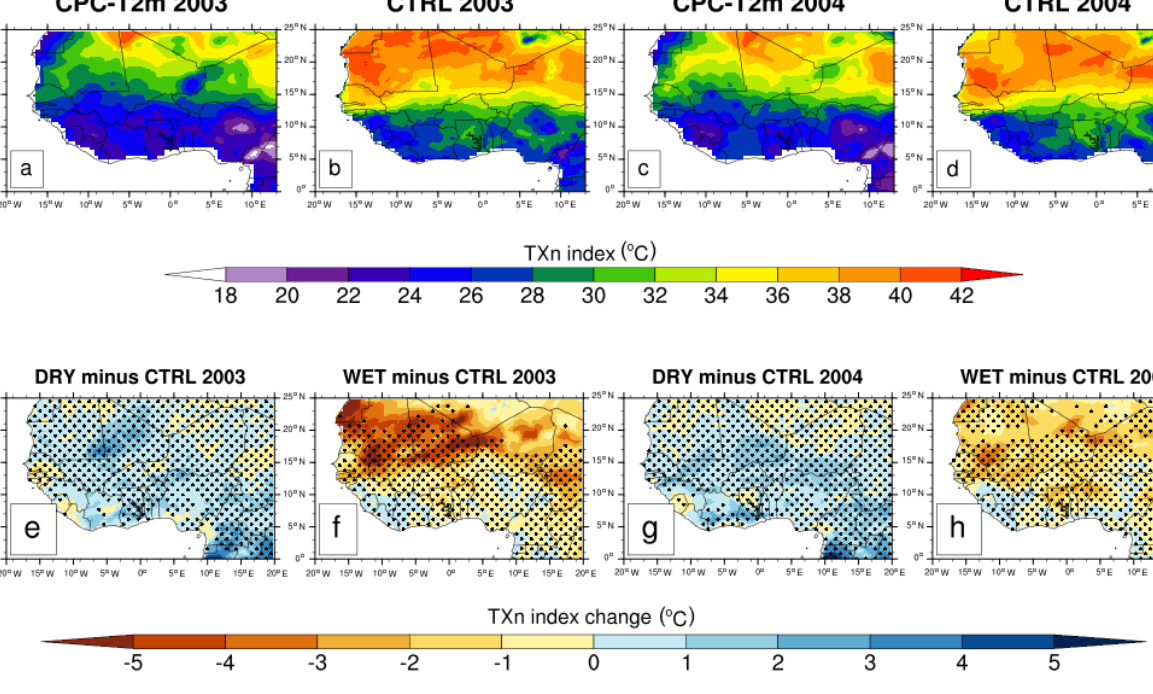
Figure 16. Same as Fig. 14 but for the TXn index.